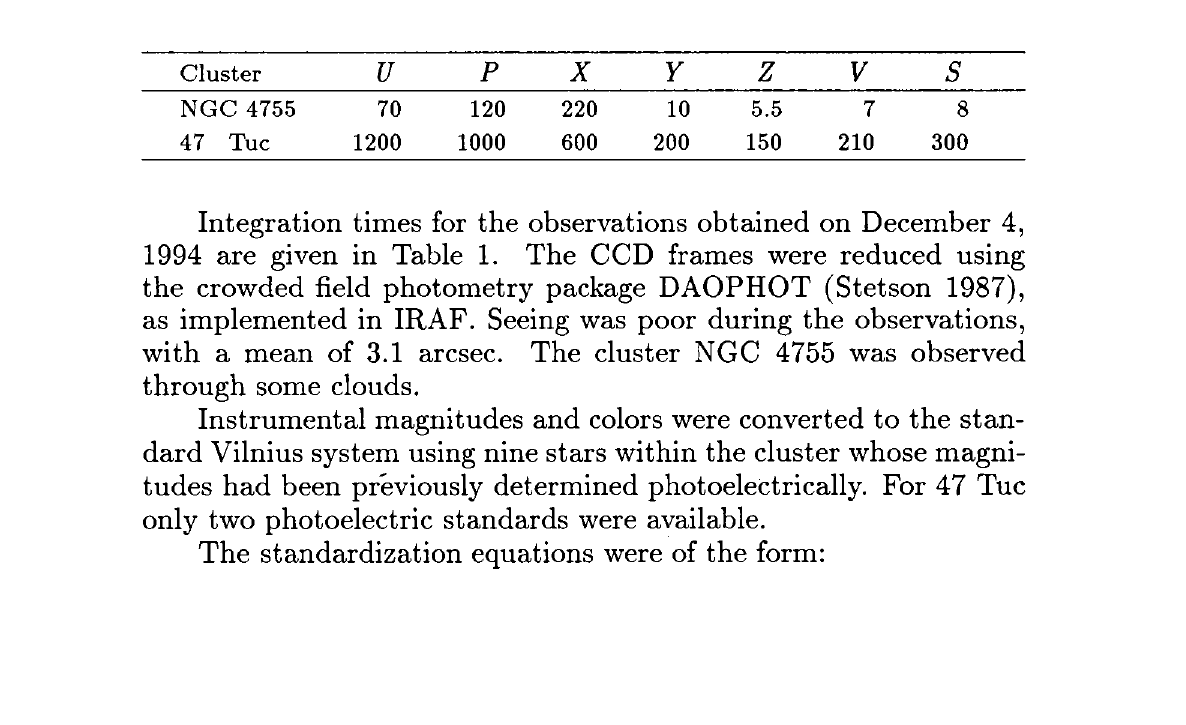
Integration times for the observations obtained on December 4, 1994 are given in Table